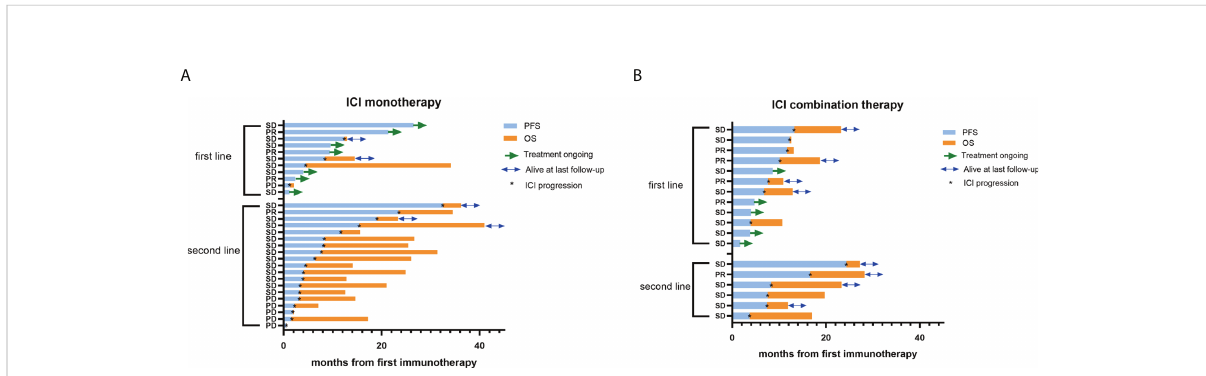
FIGURE 1 PFS and OS of PLELC treated patients with ICI monotherapy or combination therapy. (A, B) Progression-free survival ( PFS; blue bar) and overall survival (OS; orange bar) (in months) in PLELC patients who underwent treatment with ICI monotherapy or combination therapy at the initiation of fi rst immunotherapy. Best responses during the ICI treatment are shown on the y-axis. First line: fi rst-line treatment with ICI monotherapy or combination therapy. Second line: second- or more line treatment with ICI monotherapy or combination therapy. PR, partial response; SD, stable disease; PD, progression disease. Patients with green arrows were undergoing ICI treatment at the last follow-up. Patients with blue arrows were alive at the last follow-up. *: ICI